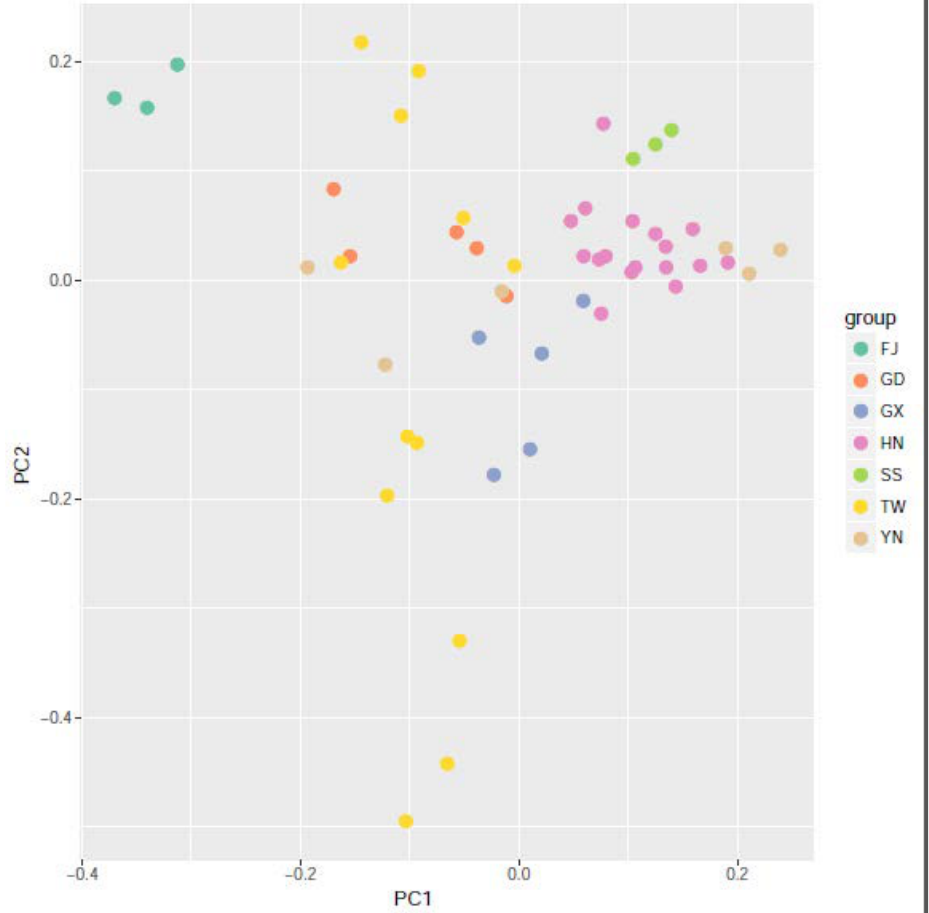
Figure 4. Principal component analysis (PCA) of genetic differentiation among B. longissima populations.